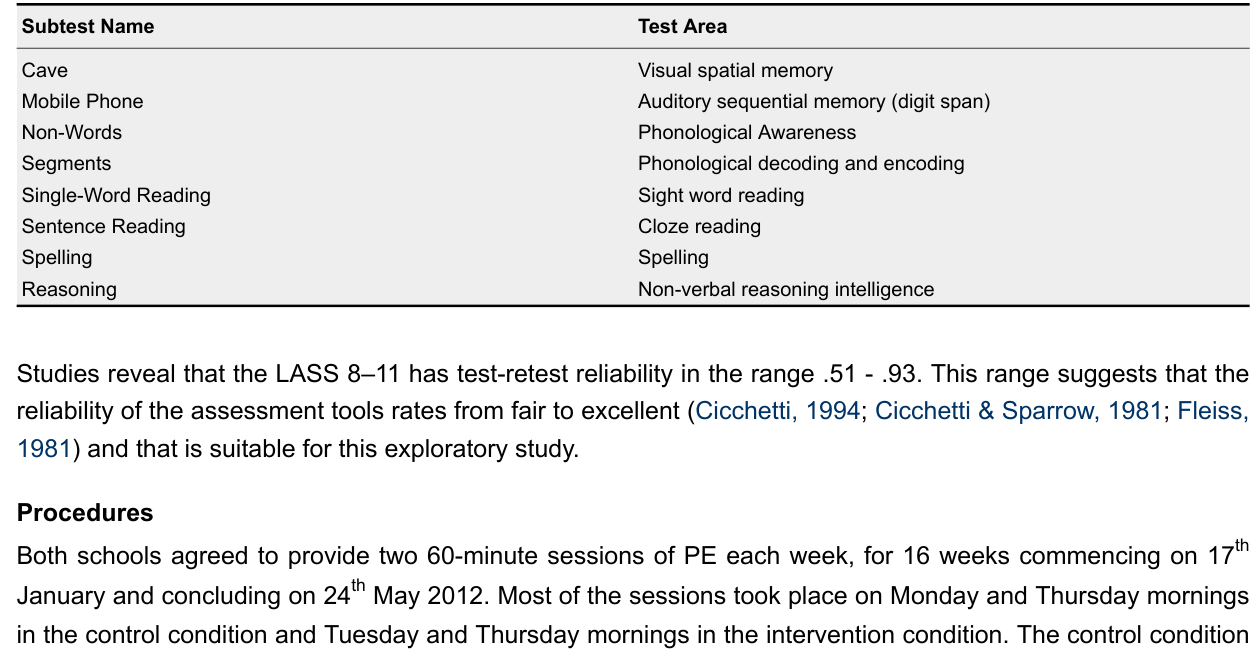
Subtest Name, Category, Type and Description for LASS